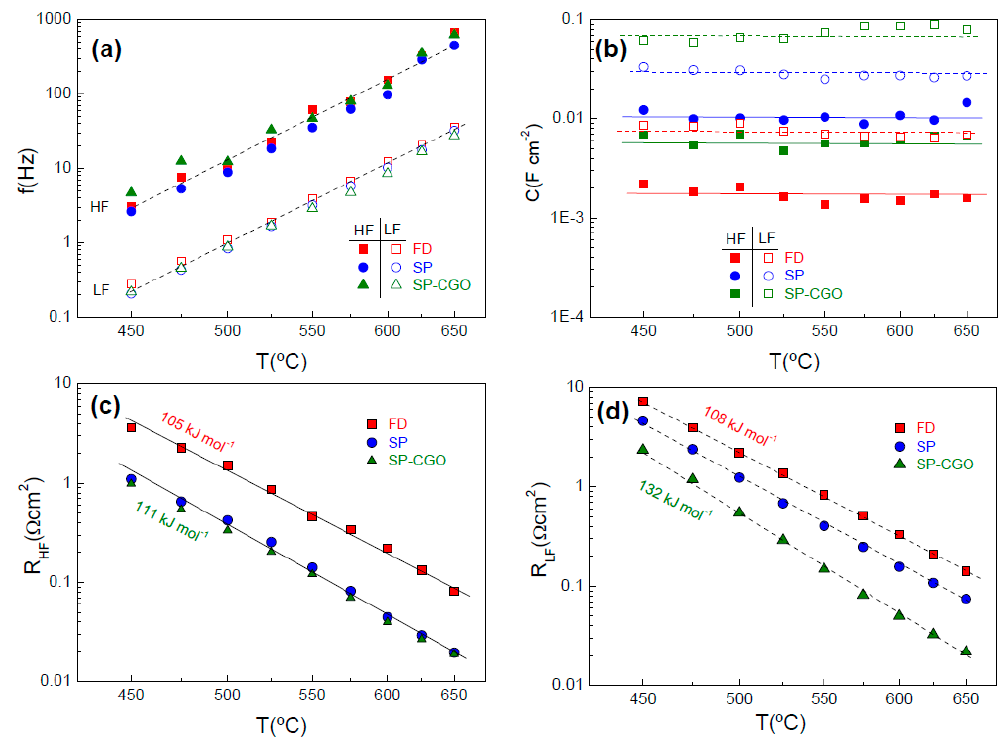
Figure 5. ( a ) Relaxation frequency, ( b ) capacitance and ( c ) R HF and ( d ) R LF resistance contributions for the different electrodes architectures.